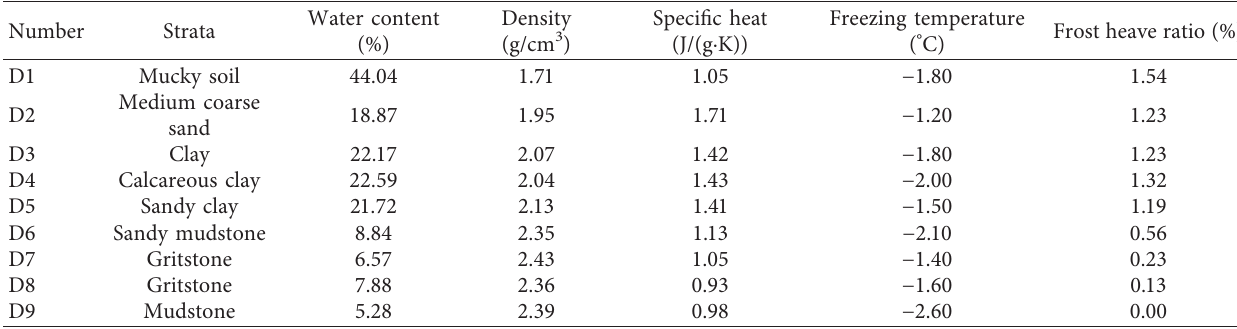
Table 2: Physical performance of different rock and soil strata determined from tests.